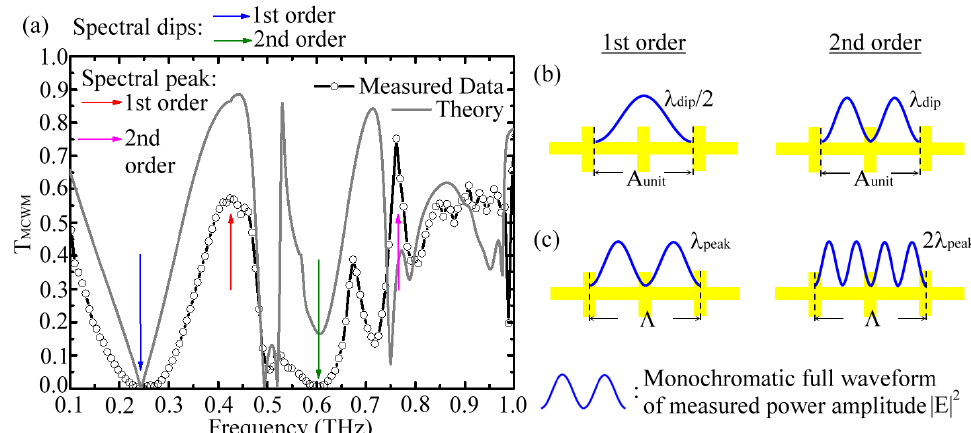
Figure 2. ( a ) Experimental and simulated transmittance spectra of 249 μ m W MCWM; schematic diagrams of the characterized spectral ( b ) dip and ( c ) peak wavelengths relating to A unit and Λ of the MCWM, respectively.